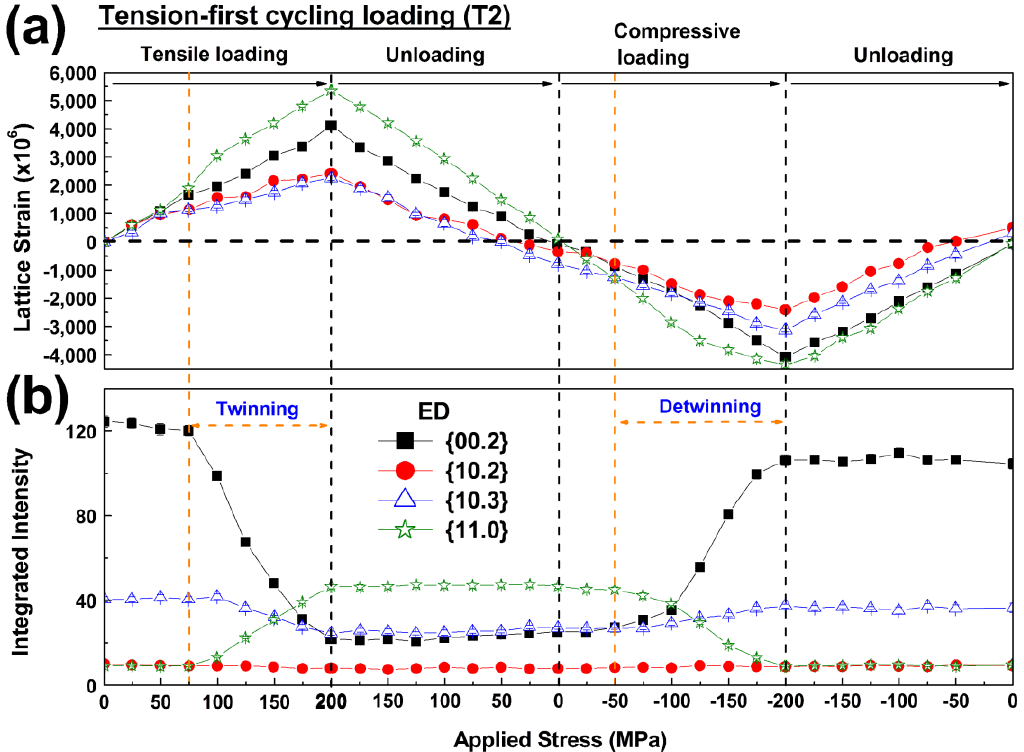
Figure 6. ( a ) Lattice strain evolution and ( b ) intensity variations for various grain families as functions of applied stress during the deformation shown in Figure 5. The { hk.l } plane normal is parallel to the applied loading direction, which is parallel to the extrusion direction